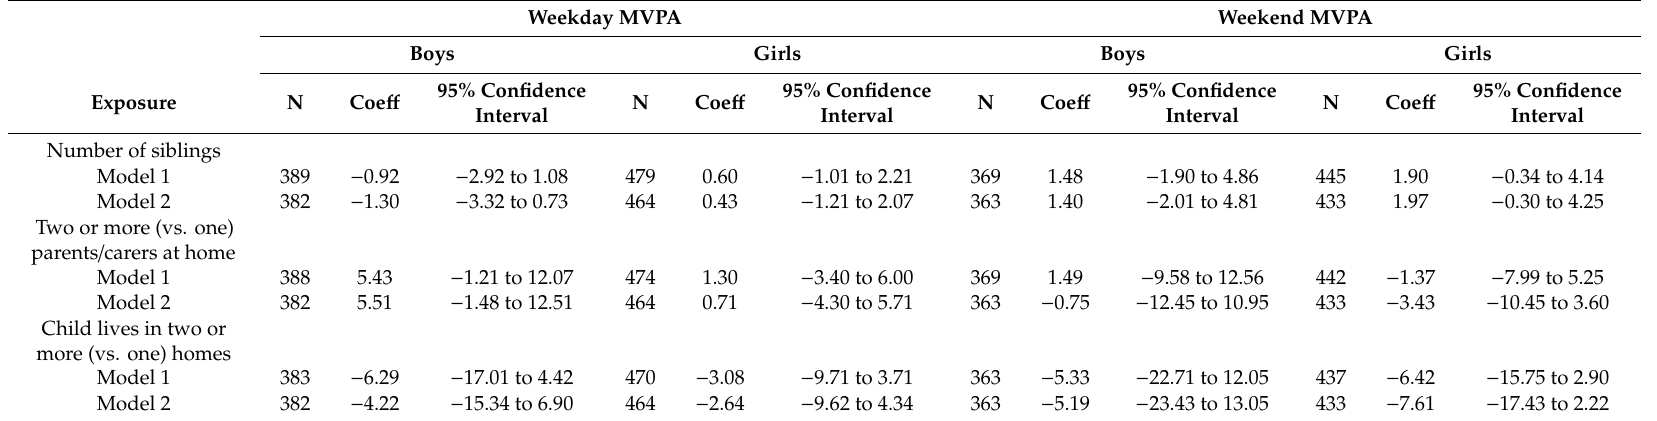
Table 3. Cross-sectional associations of weekday and weekend MVPA with family structure variables at age 9. Weekday MVPA Weekend MVPA Boys Girls Boys Girls